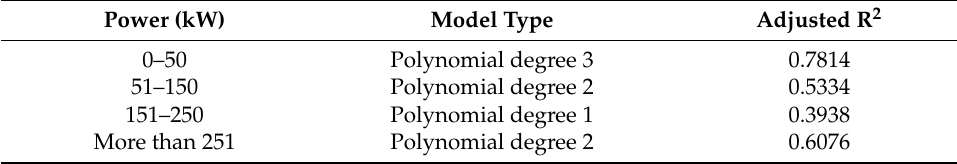
Figure 15. Price vs. power for new tractors with more than 251 kW. Table 7. Summary of results of segmentation by power for new tractors.